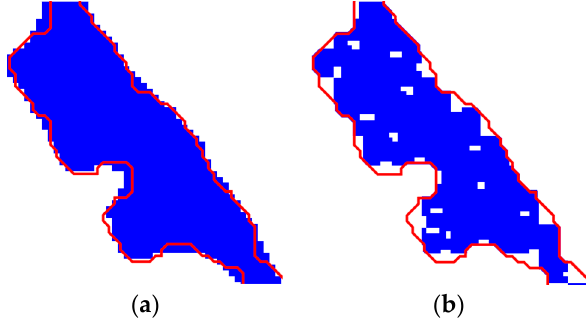
Figure 24. Sub-pixel maps derived from OBA-NDWI using ( a ) optimal pair of bands (CB and RE) against ( b ) original pair of bands (NIR1, G) for the WV-3 image.